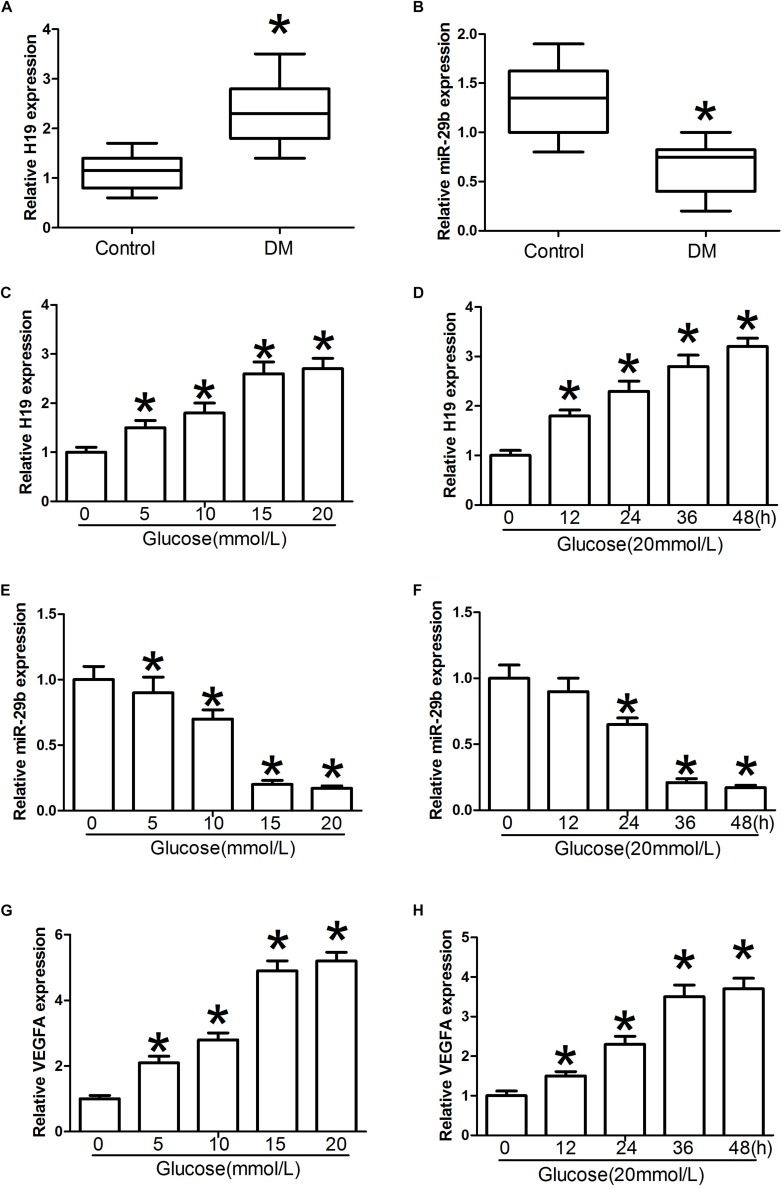
H19 and miR-29b expression in individuals with diabetes mellitus (DM) and in glucose-treated HUVECs. (A,B) Circulating lncRNA H19 and miR-29b levels were measured by RT-PCR. (C–H) Relative H19, miR-29b, and VEGFA expression about 24 h after exposure to various concentrations of glucose (0, 5, 10, 15, and 20 mmol/l) or treatment with glucose (20 mmol/l) for the indicated times. ∗P < 0.05 vs. control group.